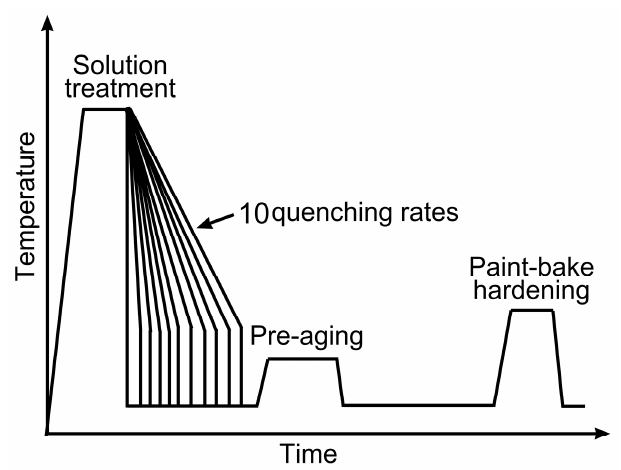
Figure 1. Representation of the heat treatment procedure.